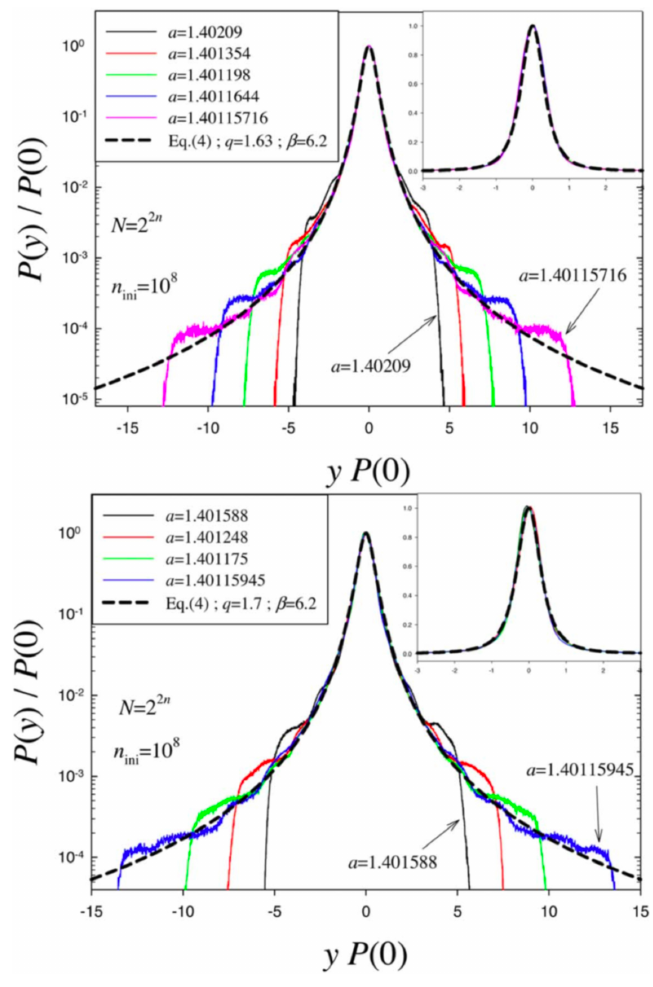
Figure 7. Data collapse of probability density functions (in log-linear plots) for T = 2 2 n , where 2 n is an odd number ( top ) or an even number ( bottom ). As n increases, good fits with q attractor -Gaussian ∝ e − β y 2 ( q attractor , β ) = ( 1.63,6.2 ) ( top ), and ( q stat , β ) = ( 1.70,6.2 ) ( bottom )) are obtained q attractor (with for increasingly large regions. Insets: Linear-linear plots of the data for a better visualization of the central part. From